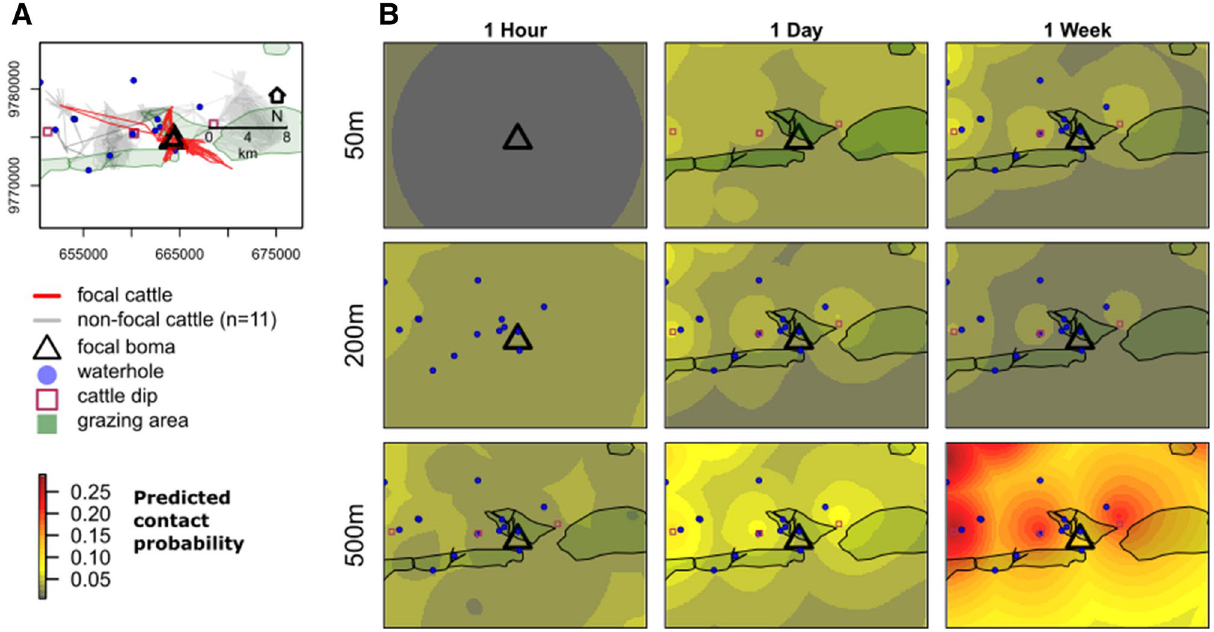
Figure 6. Predicted contact risk for a focal cattle across an agropastoral community in northern Tanzania. ( a ) GPS trajectories of focal cattle and neighboring cattle (n = 11) in relation to communal resource areas (grazing, watering and dipping points). ( b ) Relative contact risk within the same landscape is based on model predictions for a single cow originating from its home boma (black triangle) for three spatial (50 m, 200 m and 500 m) and three temporal (1 h, 1 day, 1 week) scales of contact ( c.f. Fig. 5). Extent of the mapped area is limited to the prediction range of the focal cattle, within 10 km buffer to display risk around nearby resource areas. The high risk near waterholes and dipping areas is based on the predicted values from the population-level model, so may not have been visited by the focal cattle during the study period. Resource areas are mapped if they were retained in the top candidate model. Monthly rainfall was set to median value for all predictions. Log-herd size was set to the value of the focal cattle herd (103 individuals, untransformed), representing a relatively large herd for this